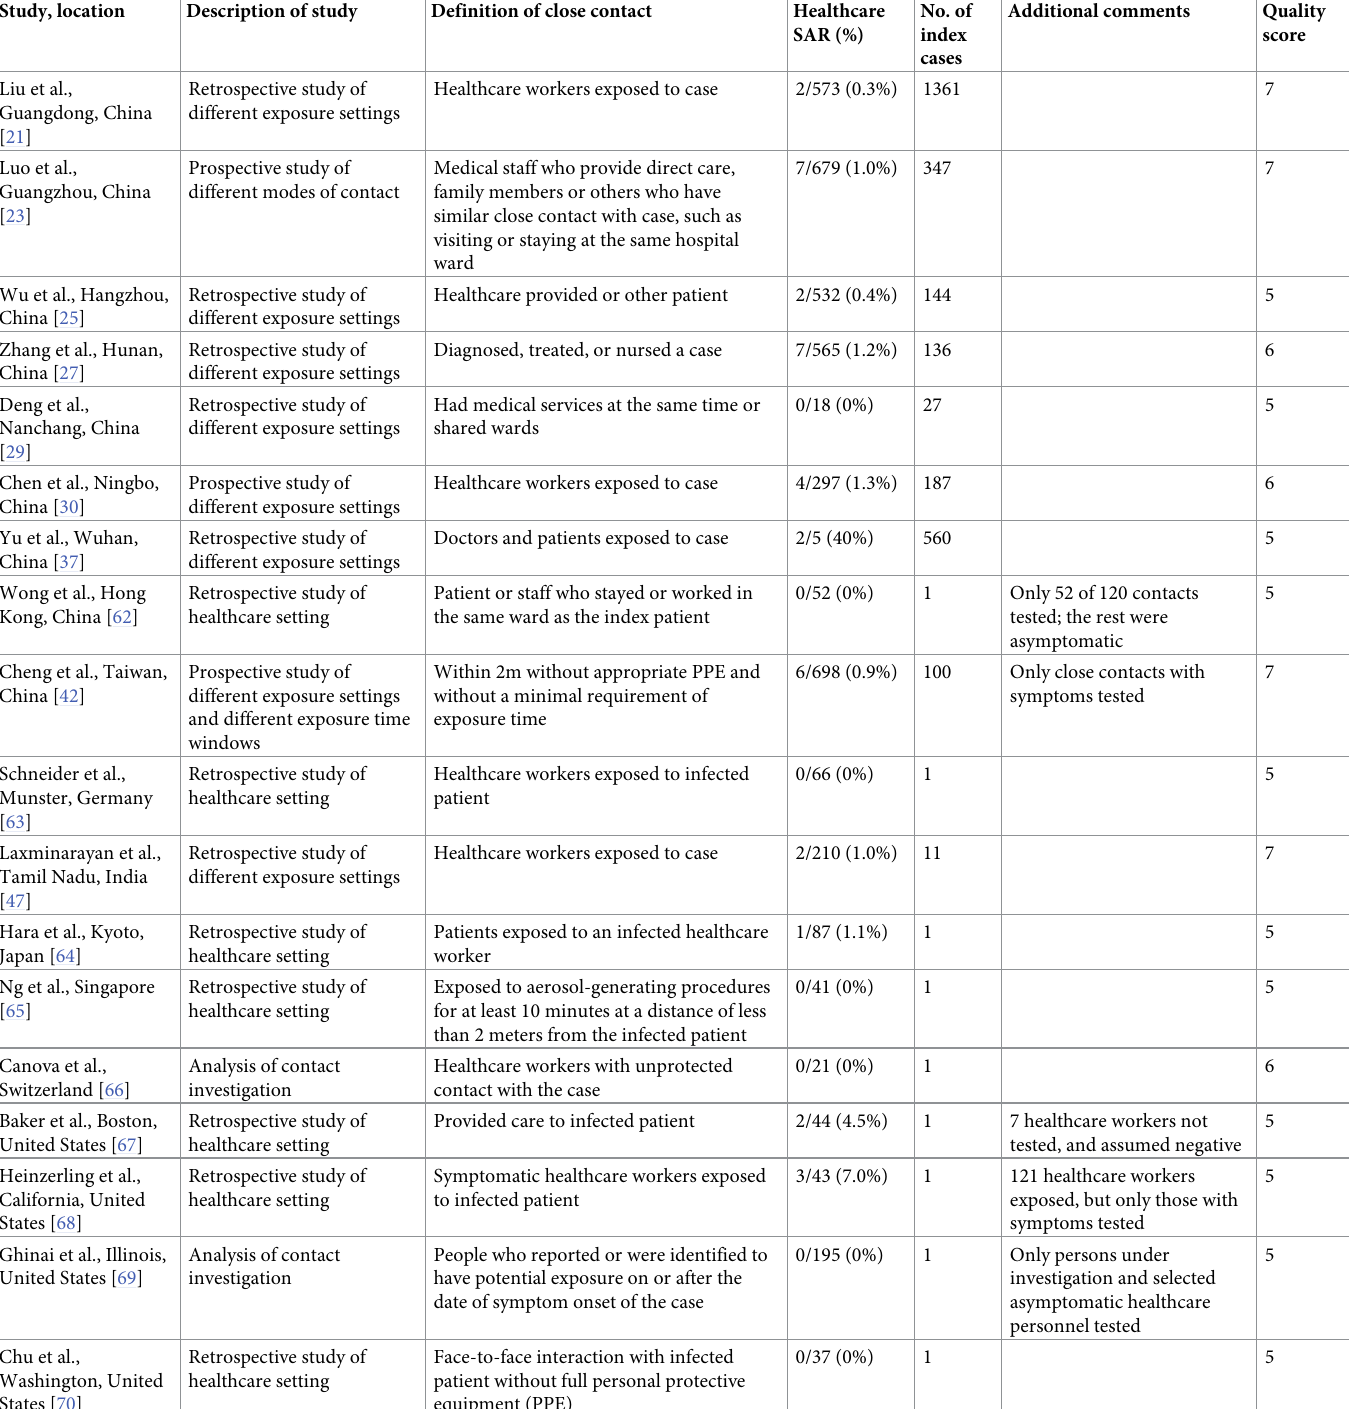
Table 2. Description of studies included in the review and analysis of healthcare secondary attack rate (SAR). Study,